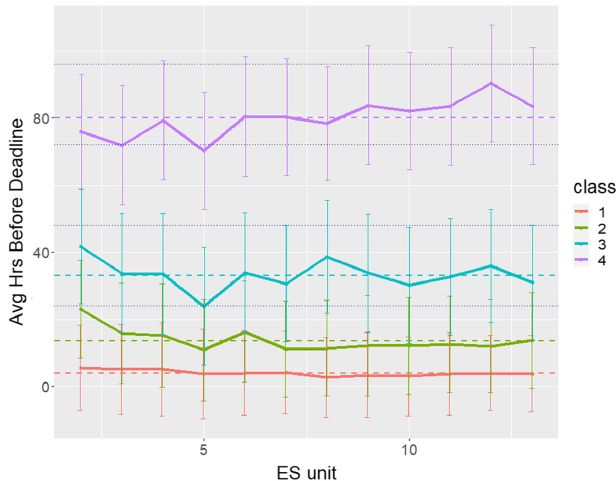
FIG. 4. For each completion class, we plotted the mean completion time for each essential skills unit (measured in units of hours before the deadline). Error bars represent 1 standard error. The dashed colored line represents the mean completion time for each class averaged over all essential skills